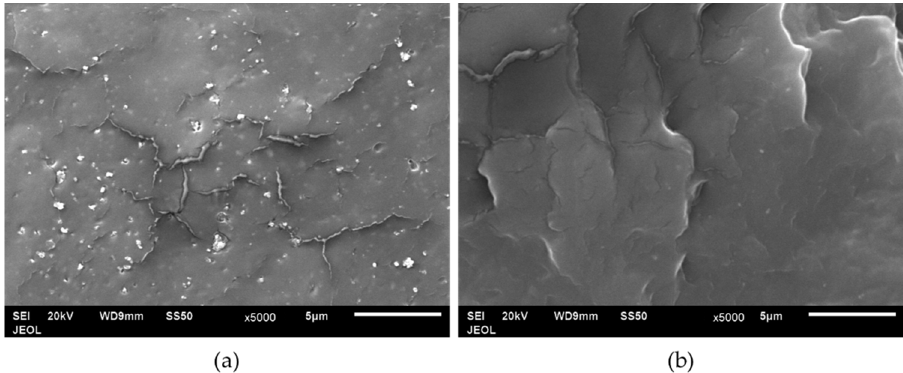
Figure 8. SEM images of 5 wt. % of nTiO 2 of PP/5nTiO 2 composites of ( a ) PP3 and ( b ) PP23.